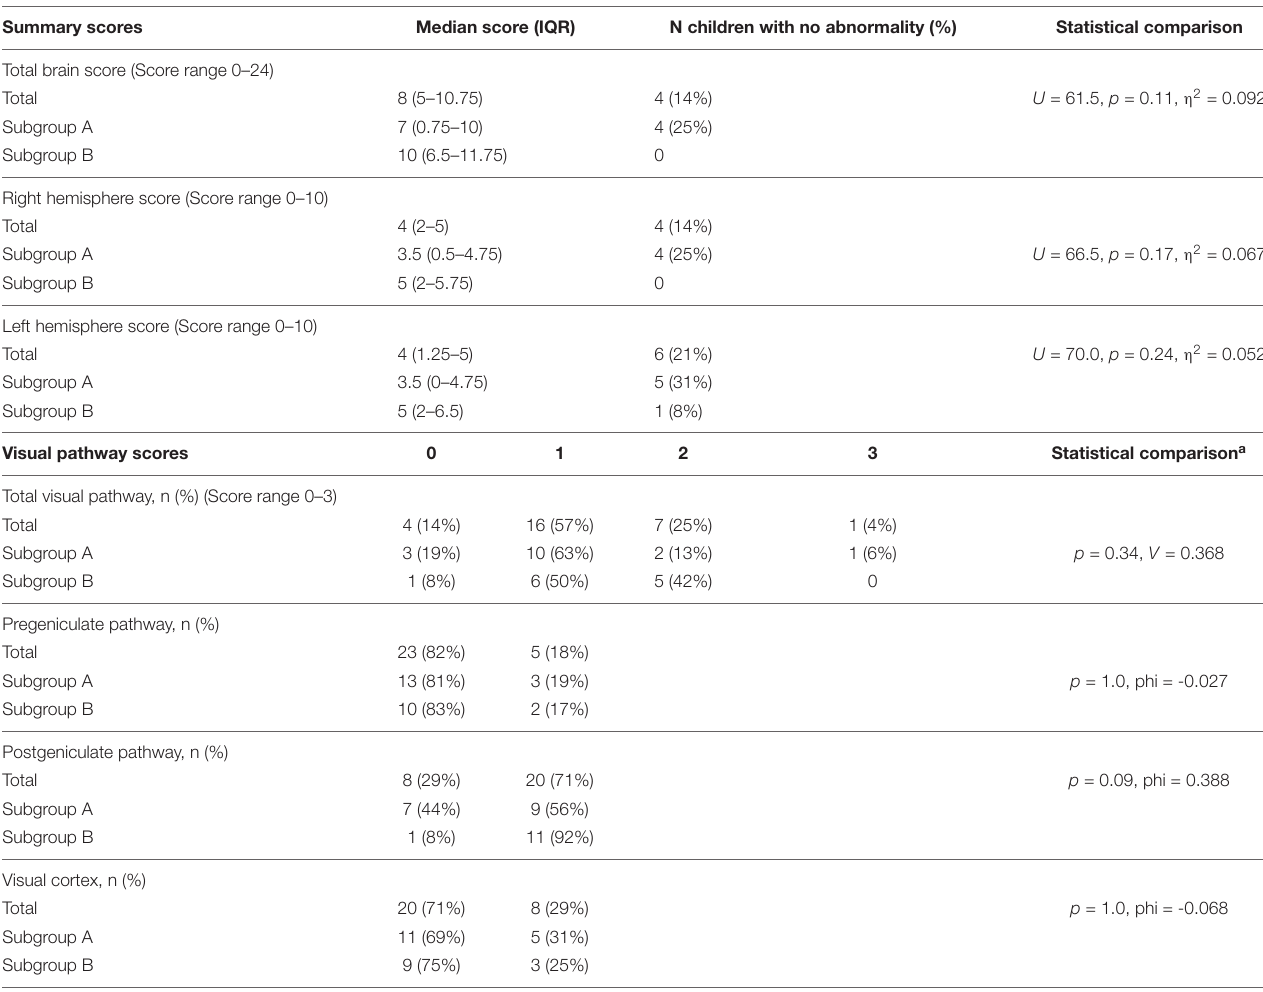
TABLE 2 | MRI brain summary scores and group